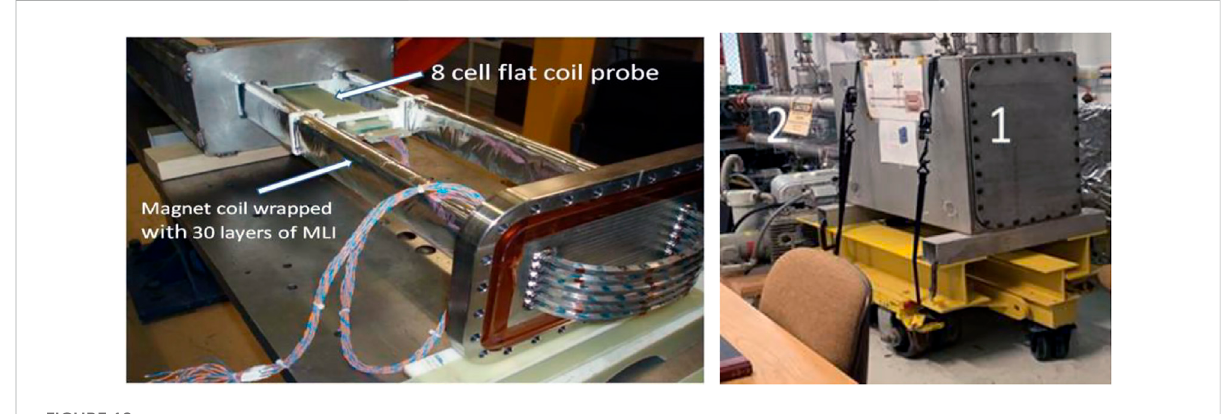
FIGURE 18 Fast cycling dipole model based on REBCO